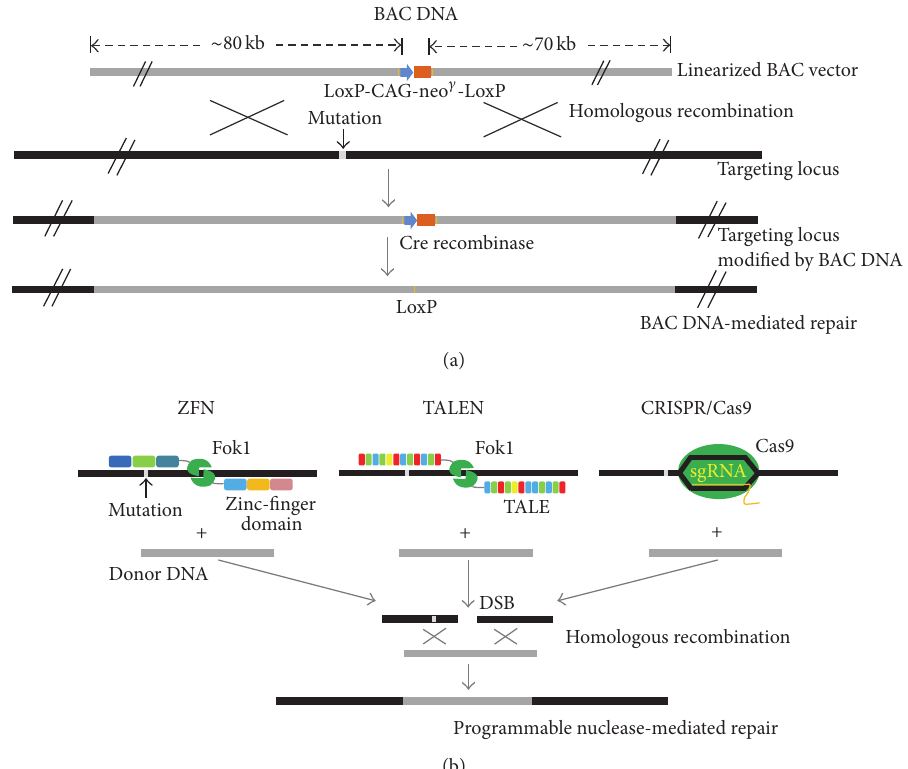
Figure 1: Mode of gene correction by gene-editing tools. (a) The image is drawn on the basis of the previous report [19]. The selection cassette (CAG-Neo 𝛾 ) is inserted into the noncoding regions of the normal BAC DNA by recombineering. The lengths of flanking homology arms are indicated. The gene harboring a mutation base is replaced with the normal BAC DNA by homologous recombination. The selection cassette is removed by Cre recombinase. (b) The programmable nuclease modes, such as ZFN, TALEN, or CRISPR/Cas9, induce DNA double- strand break (DSB) at the target locus. The mode of gene correction of programmable nucleases repairs DSB with the donor DNA, which is additionally